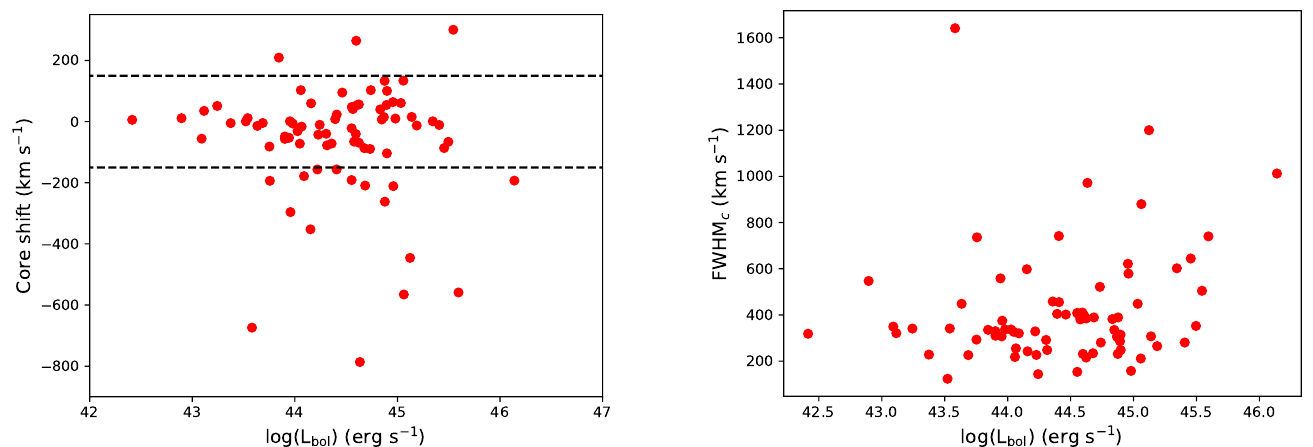
Figure 2. Left: [O III] core velocity shift in km s − 1 as a function of the bolometric luminosity in ergs s − 1 . The horizontal dashed lines indicate the limits for red or blue outliers at 150 km s − 1 . Right: FWHM([O III]) core component in km s − 1 as a function of the bolometric luminosity in ergs s − 1